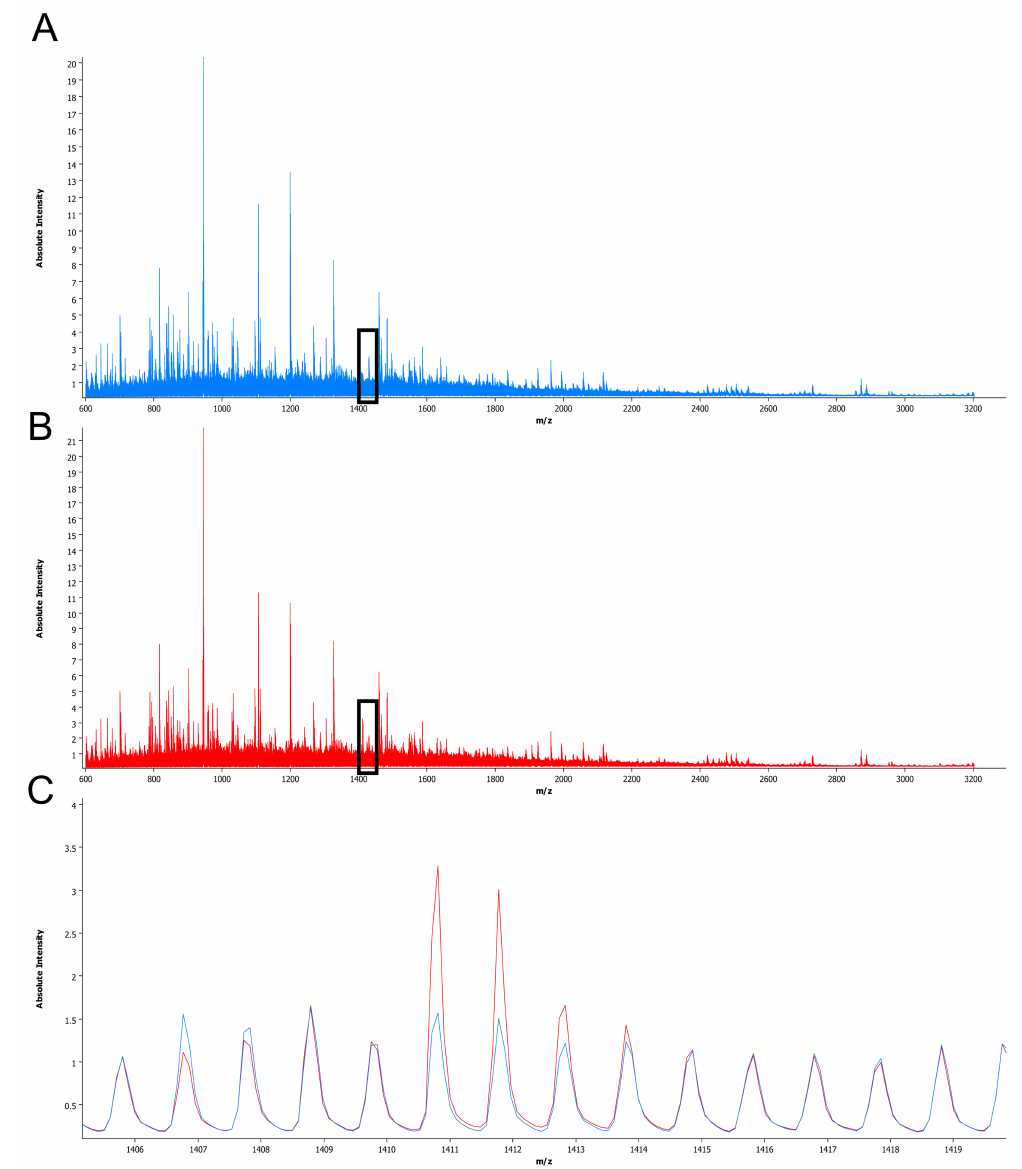
Figure 1. Sum spectra obtained from adenocarcinoma and squamous cell carcinoma samples. The mean spectra from adenocarcinomas are displayed in blue ( A ) and those from squamous cell carcinomas are displayed in red ( B ). A magnified view of the range of m / z 1406–1419 ( C ), black triangle in ( A ) and ( B